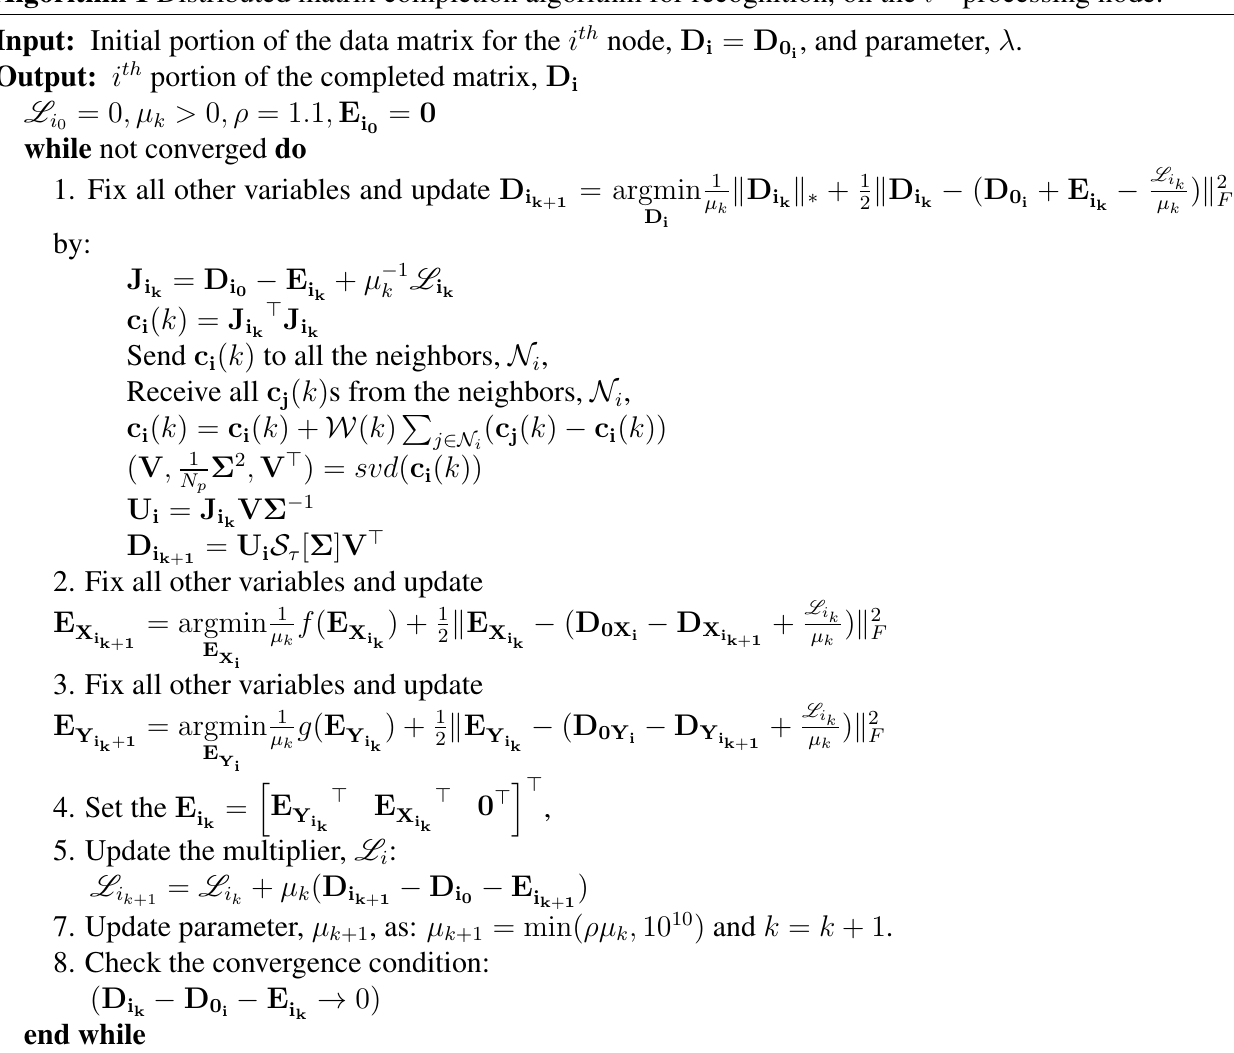
Algorithm 1 Distributed matrix completion algorithm for recognition, on the i th processing